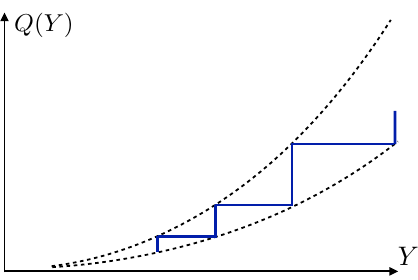
Figure 1 . Could Q ( Y ) oscillate between two di(cid:11)erent powerlaw asymptotics? We will show that such a behavior is